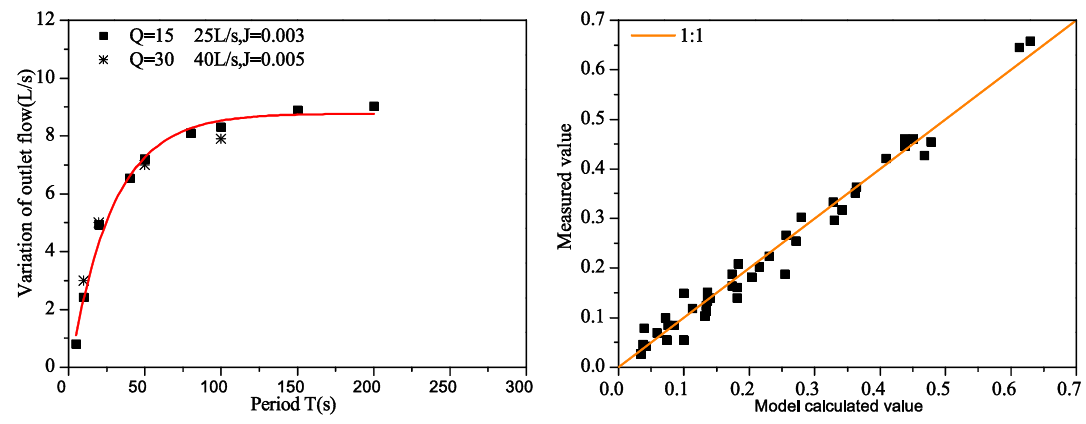
Fig. 5 Comparison of the calculated and measured outlet amplitude values